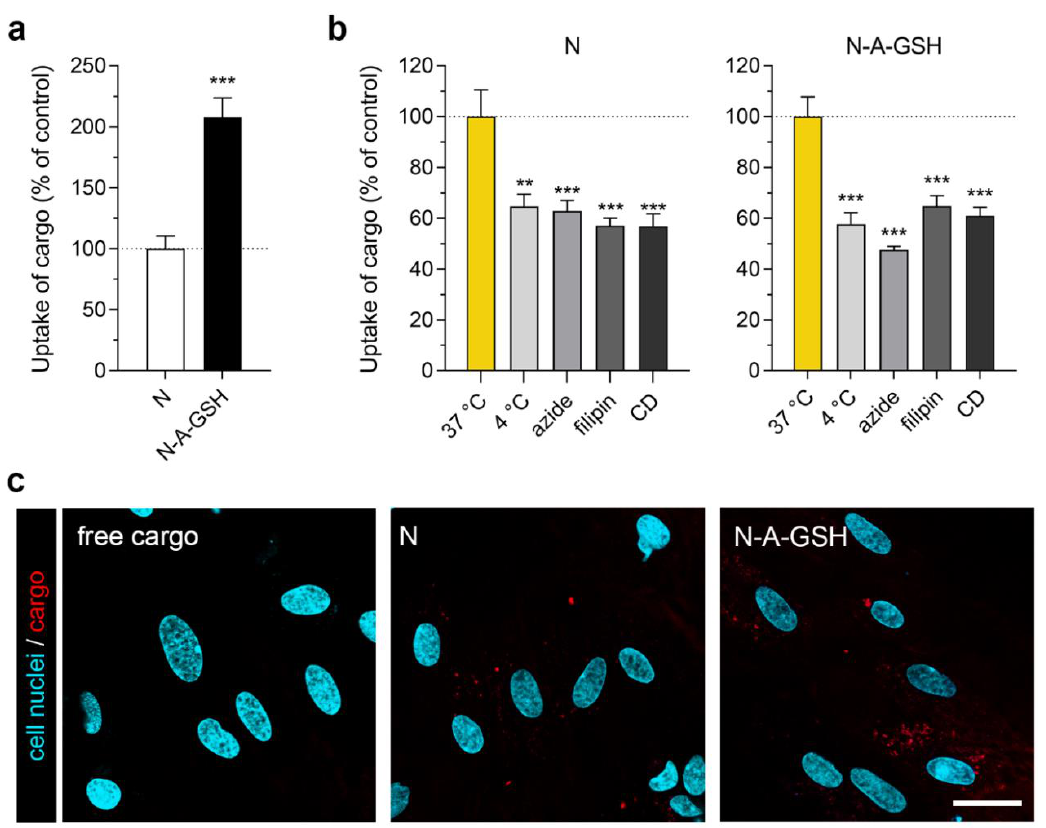
Figure 4. Cellular uptake of niosome cargo in cultured primary rat pericytes (RPC) after 4 h of